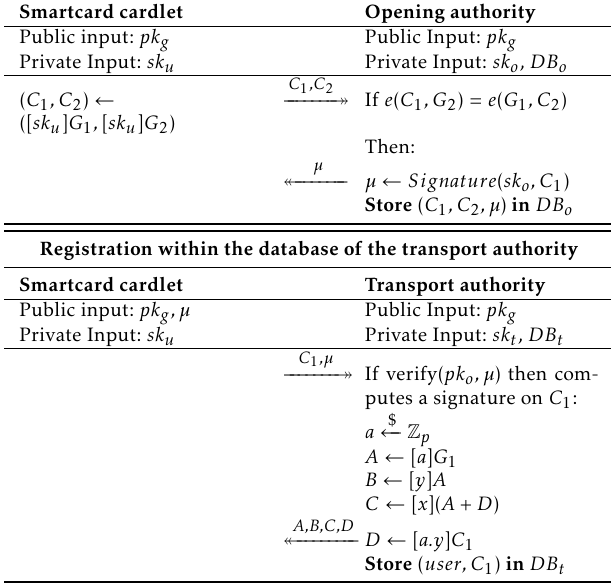
Table 1. Protocols for the registration